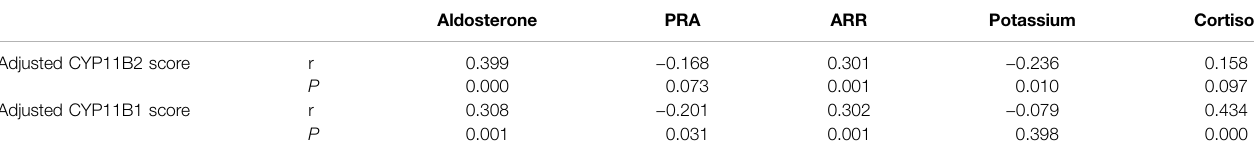
TABLE 3 | Results of Spearman ’ s correlation test between immunohistochemical staining scores and clinical parameters. Aldosterone